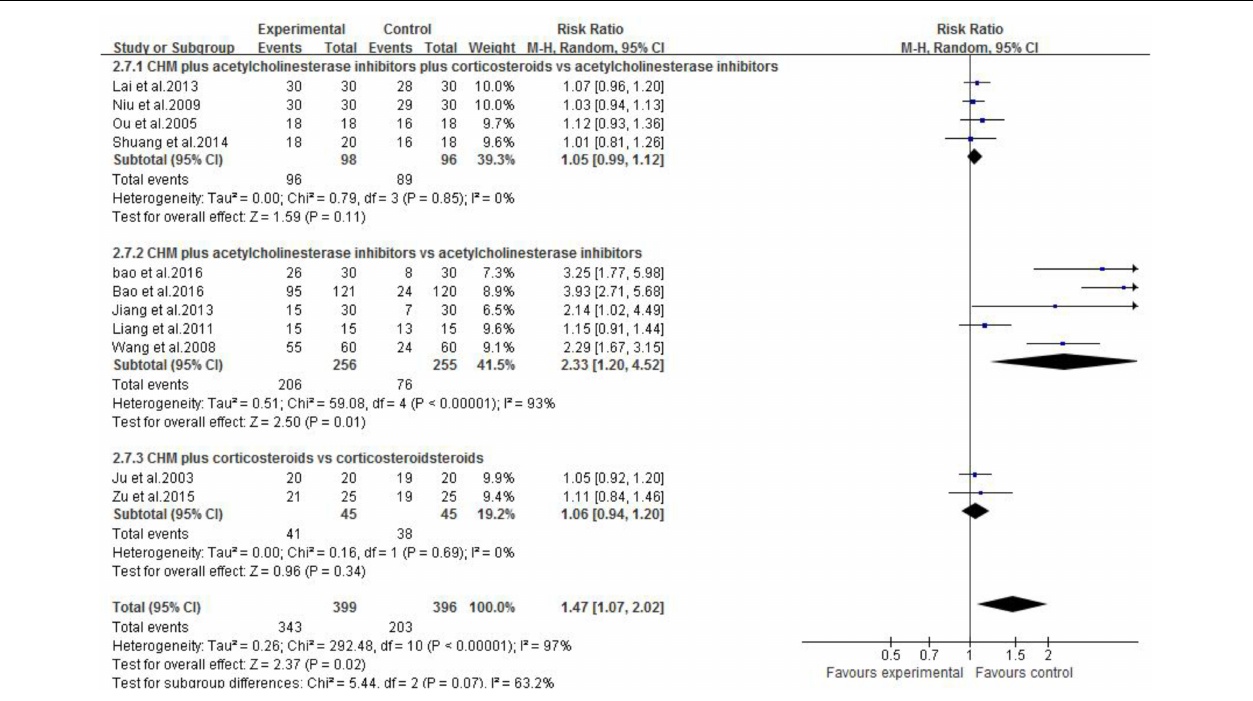
FIGURE 5 | The forest plot: The total clinical effective rate of CHM plus WCM vs. WCM.